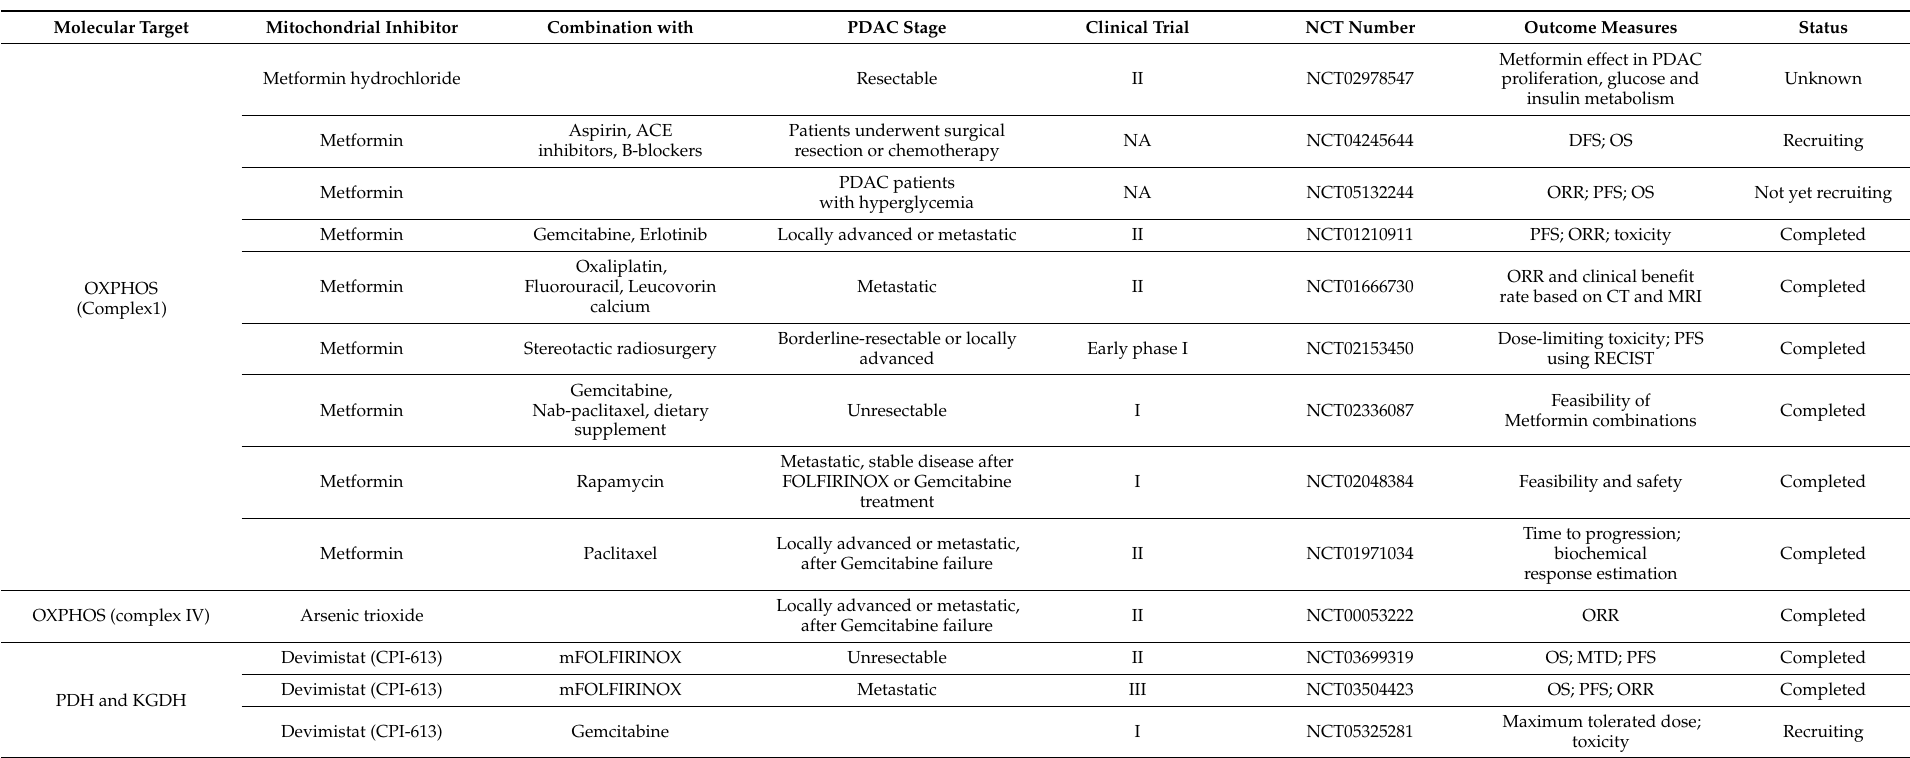
Table 2. Clinical trials against PDAC using mitochondrial metabolism inhibitors. (Data source: https://clinicaltrials.gov/ [187]. Accessed on 25 January 2023). Molecular